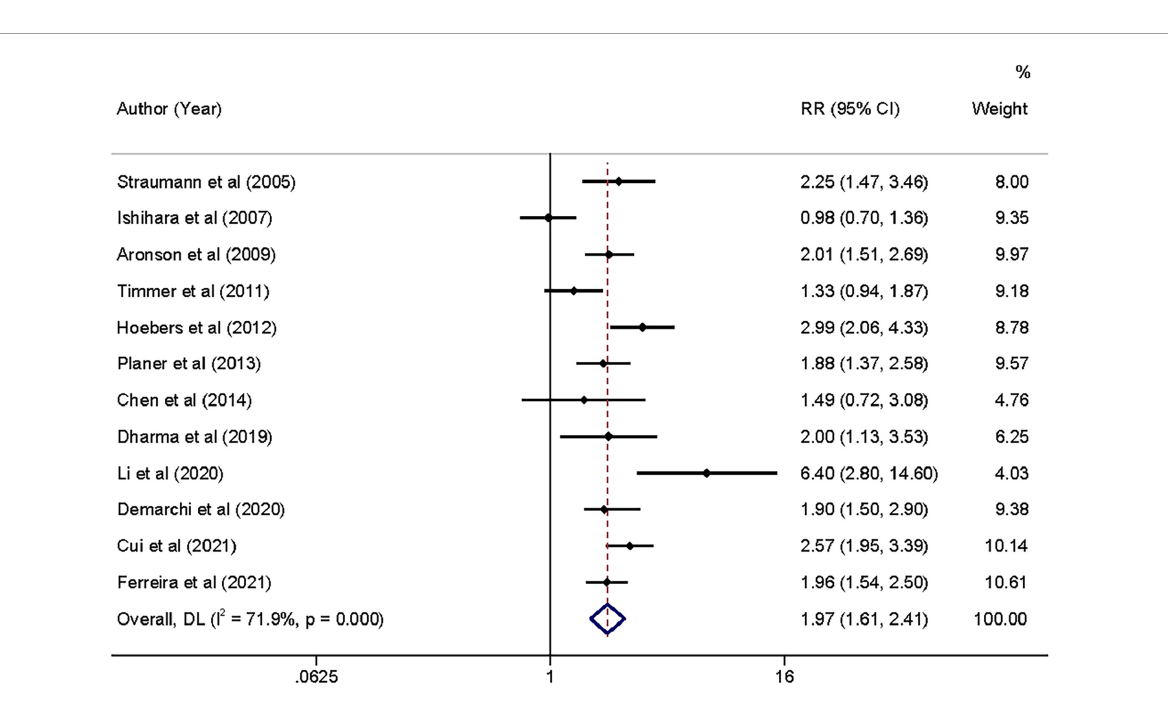
FIGURE4 Forrest plot of admission hyperglycemia associated with the long-term all-cause mortality risk. Weights are from random-effects